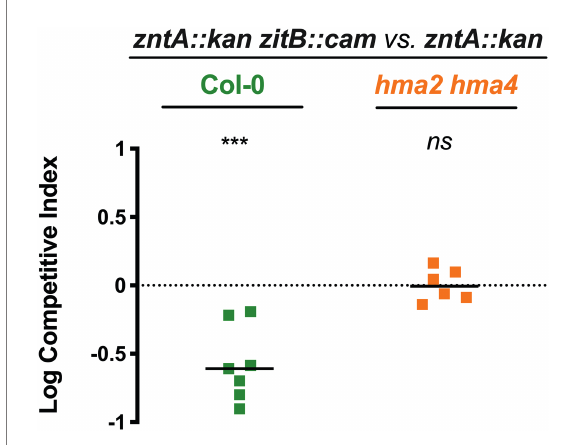
FIGURE 6 The lack of ZitB influences Salmonella persistence in Arabidopsis thaliana shoots. Competition assays in Col-0 and hma2/hma4 between zntA::kan zitB::cam (strain A) and zntA::kan (strain B). Competitive indexes were calculated as described in section “Materials and methods,” and the statistical significance was determined by the Student’s t -test (*** p < 0.005; ns, not significant). The diagram shows a representative experiment of two independent